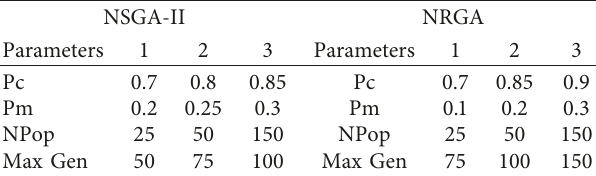
Table 4: Parameters for NSGA-II and